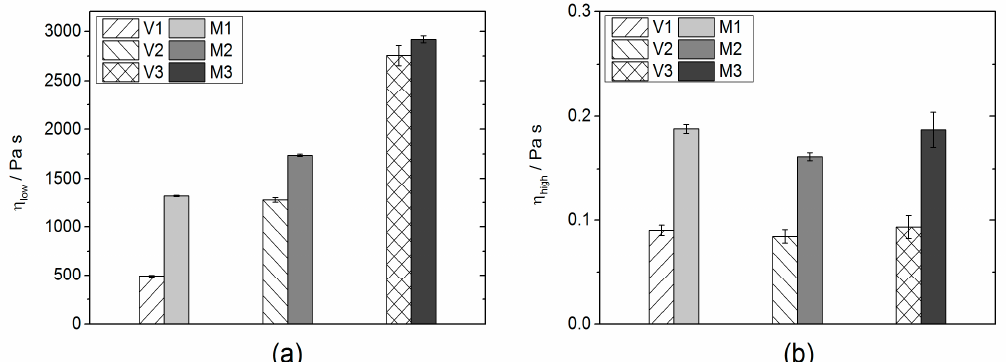
Figure 2. ( a ) Low shear viscosity values determined from rotational rheometry (parallel-plate geometry, d plate = 25 mm, R q = 2–4 µm, h = 1 mm) at γ(cid:4662) = 0.5 s − 1 ; ( b ) High shear viscosity results . γ determined using a capillary rheometer ( L nozzle = 40 mm, d nozzle = 0.5 µm) at γ(cid:4662) = 3 ⋅ × 10 5 s − 1 . Patterned a capillary rheometer ( L nozzle = 40 mm, d nozzle = 0.5 µ m) at = 3 × 10 5 s − 1 . Patterned bars correspond bars correspond to vehicles, filled bars represent silver pastes. to vehicles, filled bars represent silver